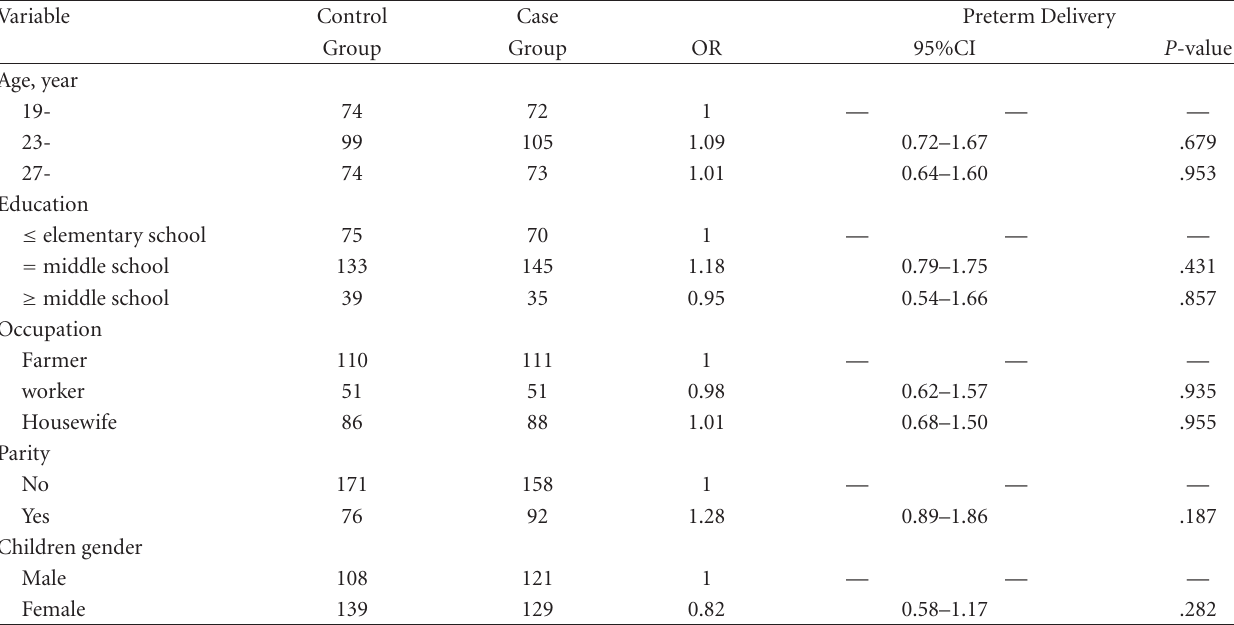
Table 1: Some general characteristics of mothers and children.